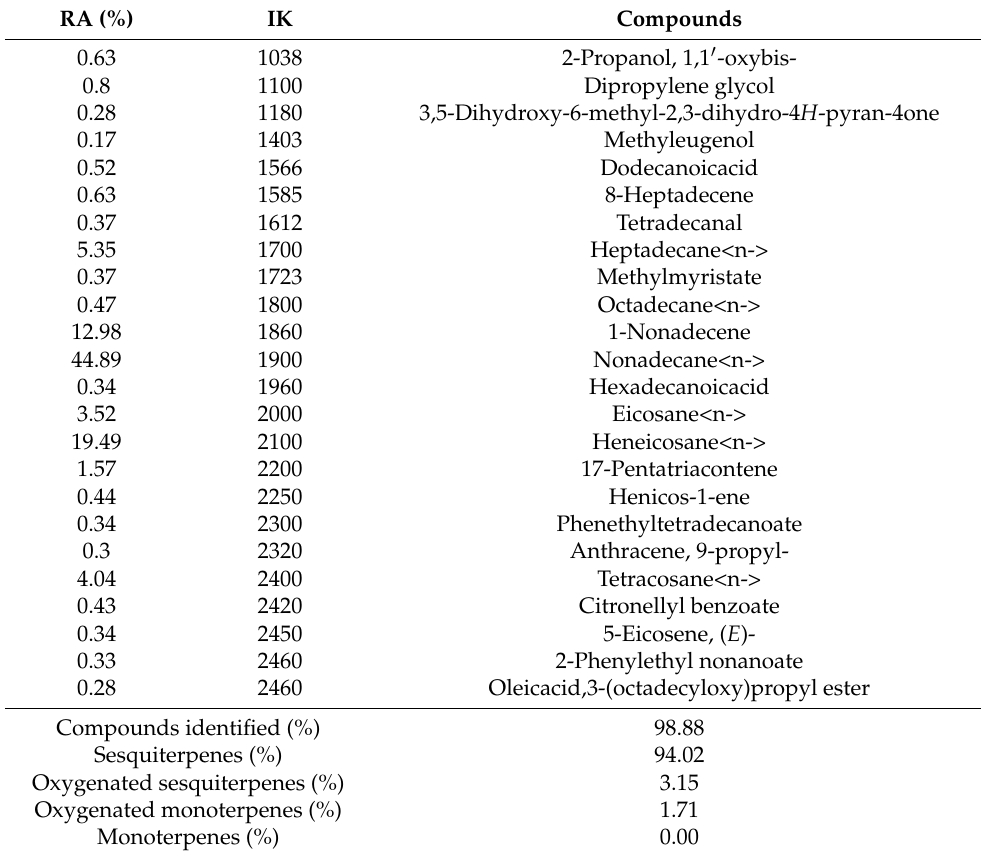
Table 10. The chemical composition of EO of Rosa damascene